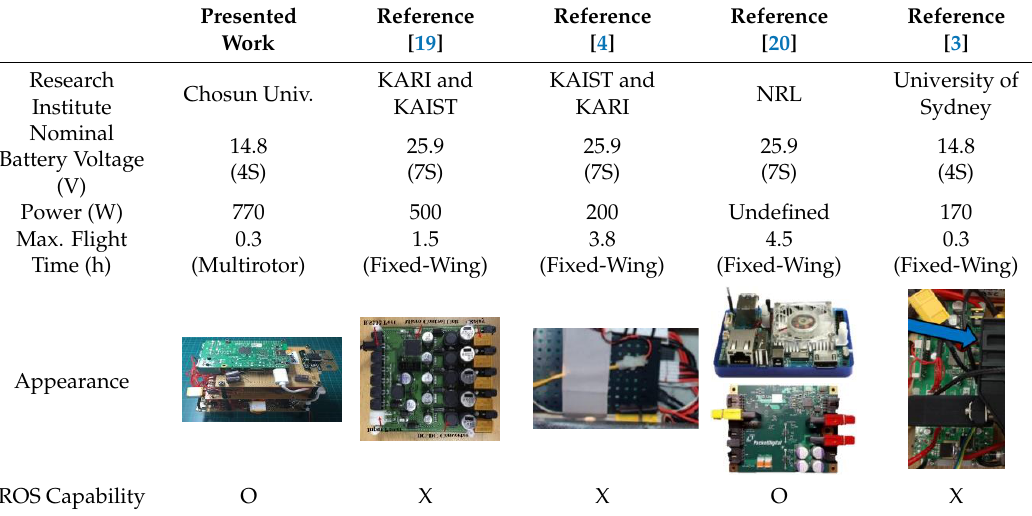
Table 6. Comparison of the HPC boards managing PV, a fuel cell, and a battery pack.